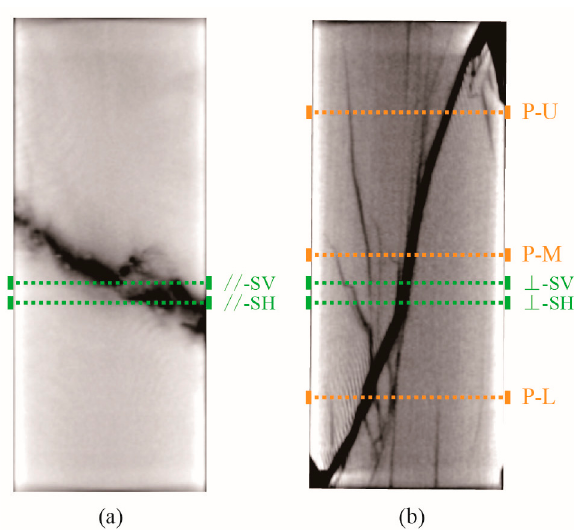
Figure 8. CT scanning slices of the sample along the axial direction and normal to the bedding plane. The labels ( a – e ) indicate the position of selected slices from x = − 22.5 mm to x = 22.5 mm with 11 mm intervals.